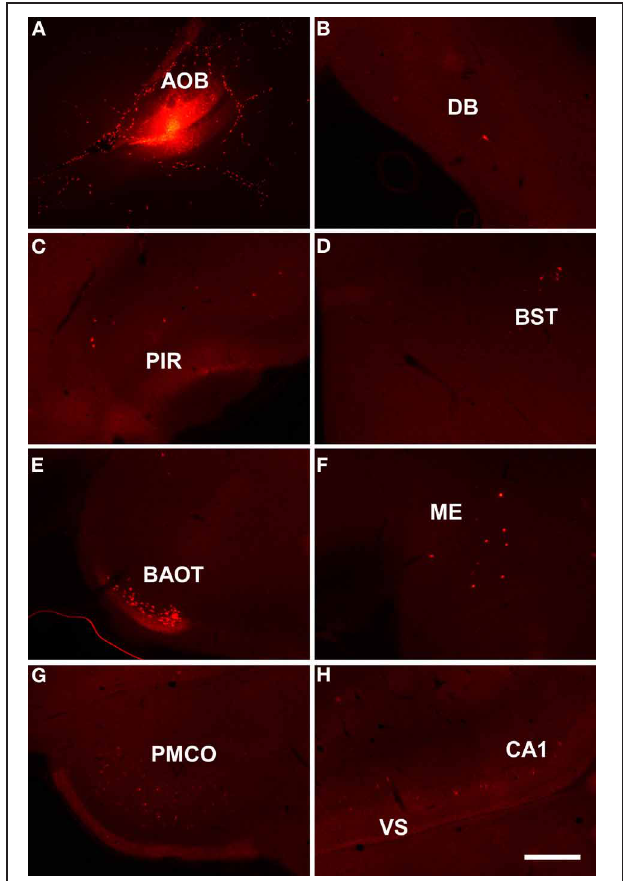
FIGURE 2 | Sagittal (A) and coronal sections (B–H) from rostral to caudal levels of the telencephalic hemisphere showing the resulting labeling (B–H) after a dextran-amine labeled tetramethylrhodamine injection in the rat main olfactory bulb (A). Abbreviations: AA, anterior